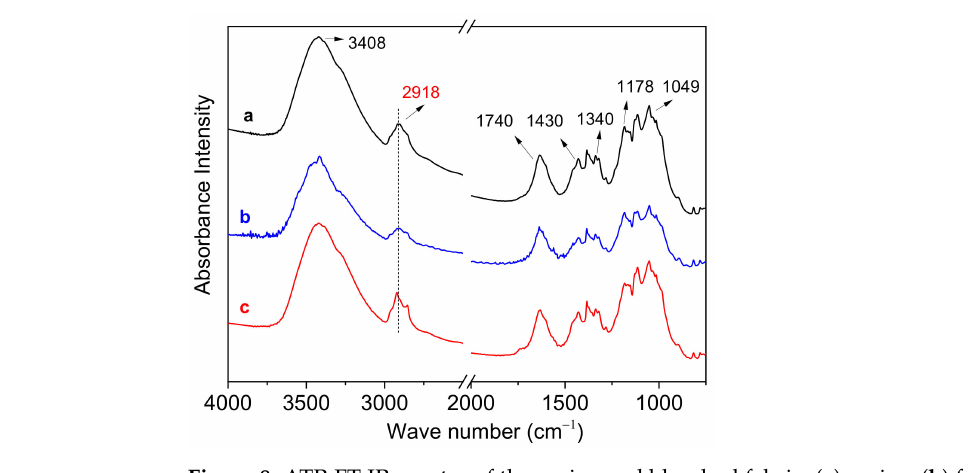
Figure 8. ATR FT-IR spectra of the greige and bleached fabric: ( a ) greige, ( b ) fabric bleached using the SPC-activated system and ( c ) fabric bleached using a conventional